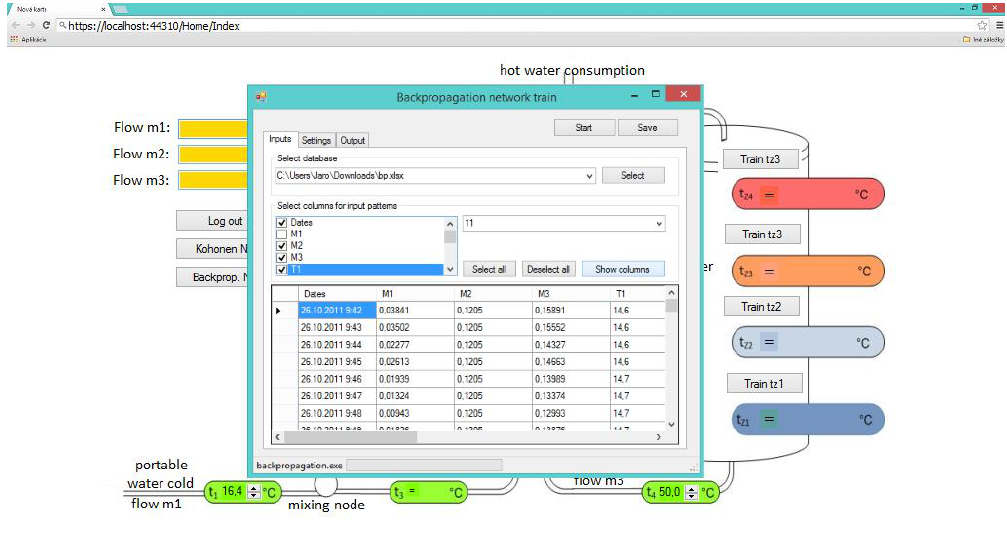
Figure 5. The user interface of the Web based Virtual Water